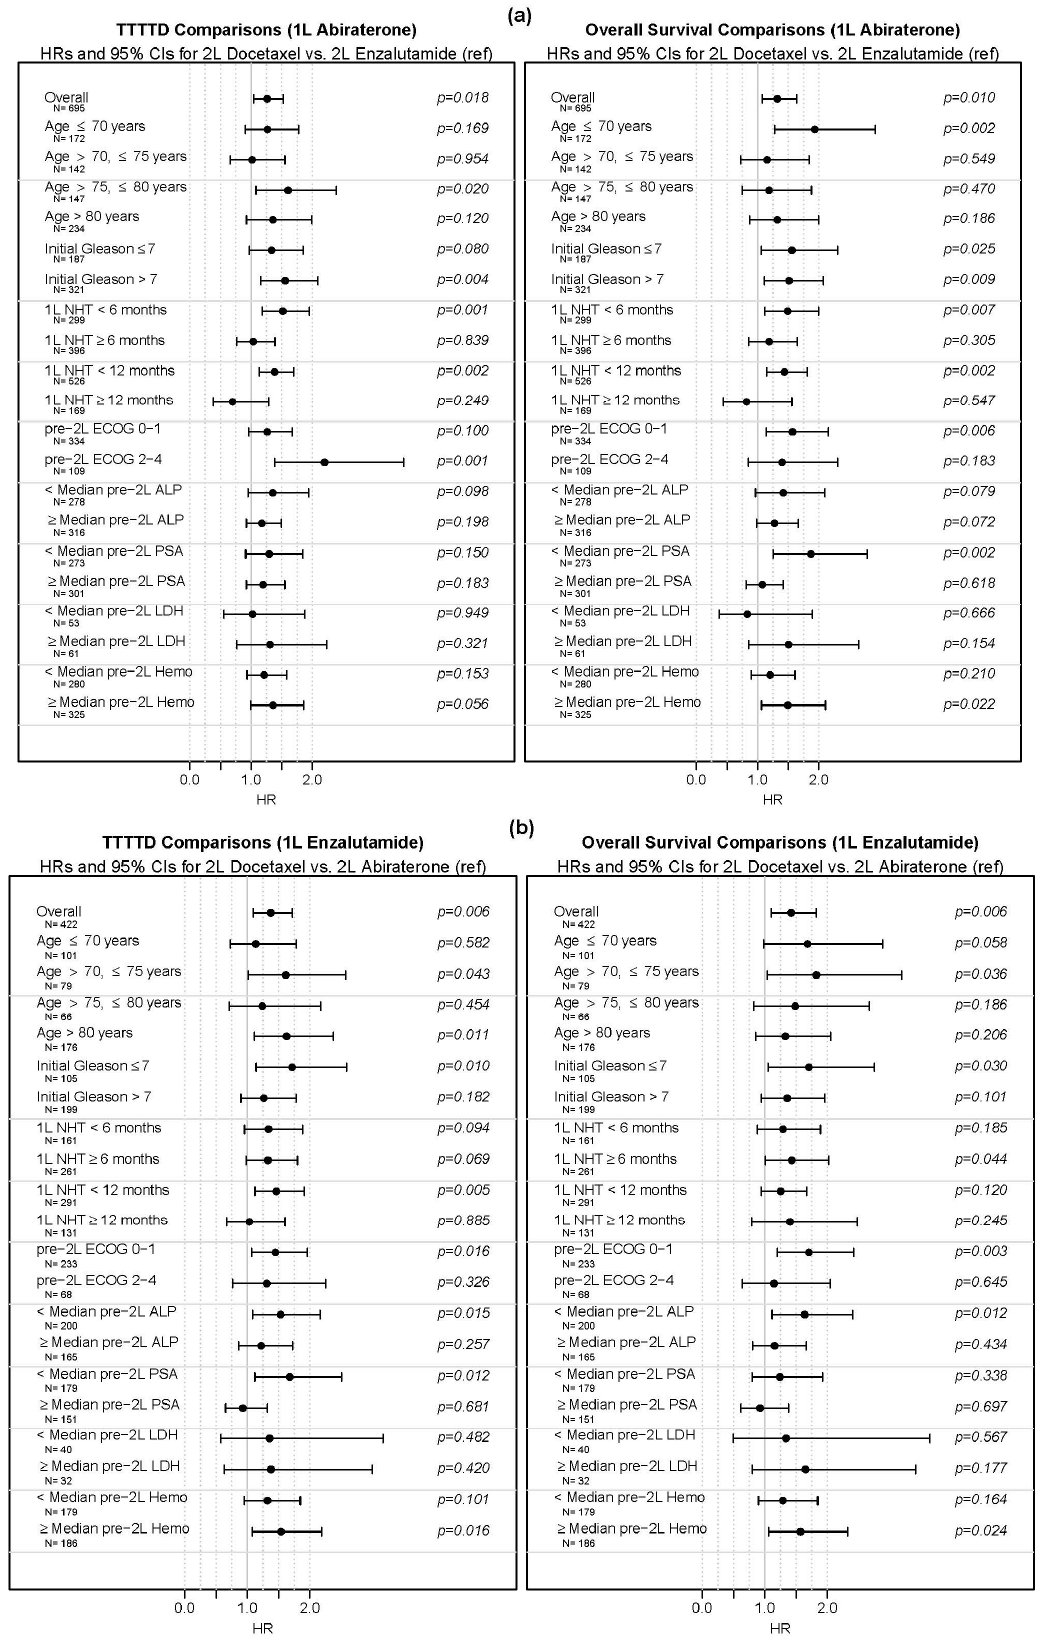
Figure 7. Time to third treatment (TTTTD) and overall survival (OS) comparisons between alternate novel hormonal therapy and docetaxel in patients treated with ( a ) first-line abiraterone (Figure 2a) and ( b ) first line-enzalutamide (Figure 2b).